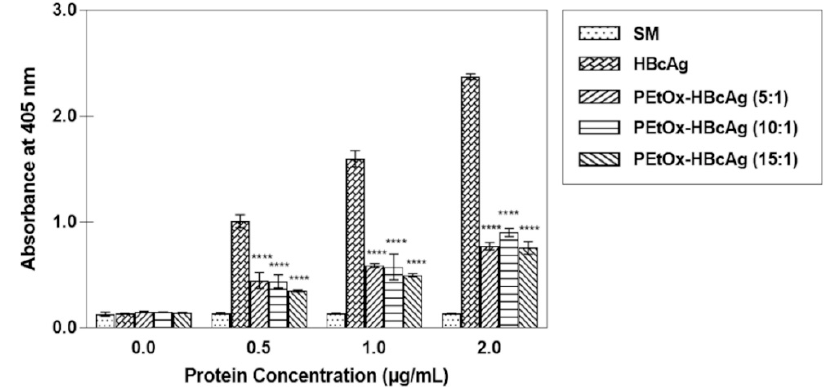
Figure 5. Antigenicity of the PEtOx-conjugated HBcAg (PEtOx-HBcAg) VLNPs at different protein concentrations with different molar ratios of PEtOx-NH 2 to HBcAg VLNPs: PEtOx-HBcAg (5:1, 10:1, and 15:1). ELISA assays were performed in triplicate ( n = 3), and the error bars represent the standard deviation from triplicate measurements. **** p < 0.0001 indicates the significant difference of PEtOx- HBcAg VLNPs compared with HBcAg VLNPs (positive control). Skim milk (SM) served as the negative control.